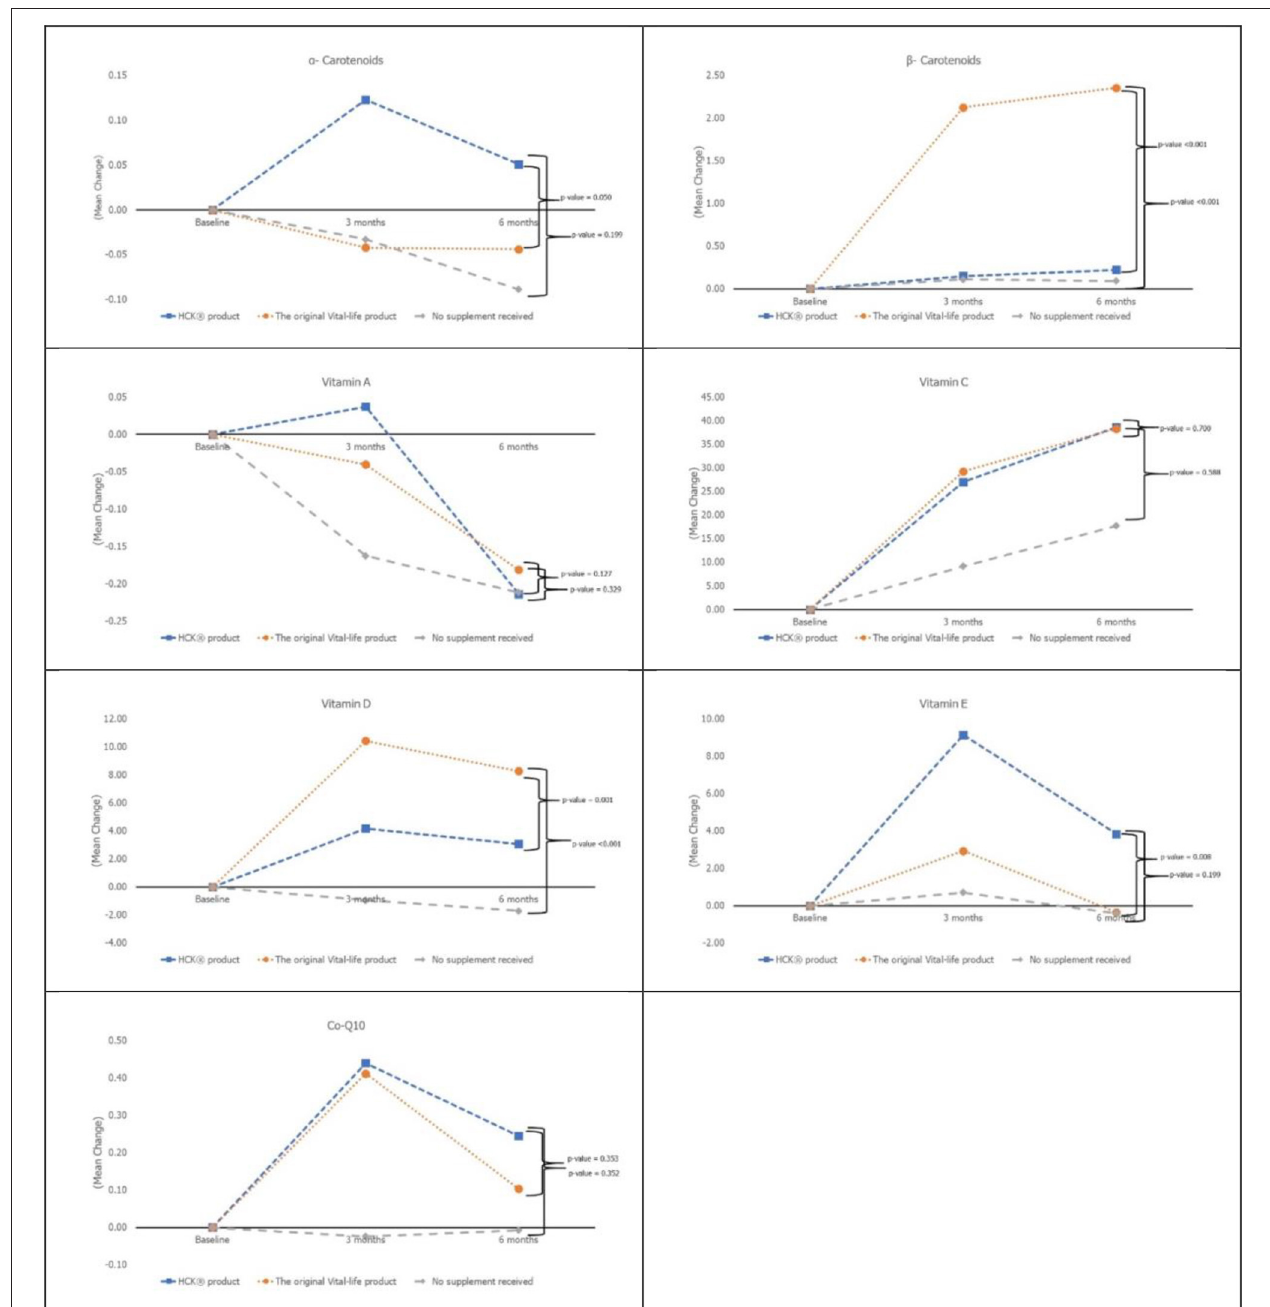
FIGURE 2 | Micronutrient levels at baseline, month 3 and 6 among all 3 groups.